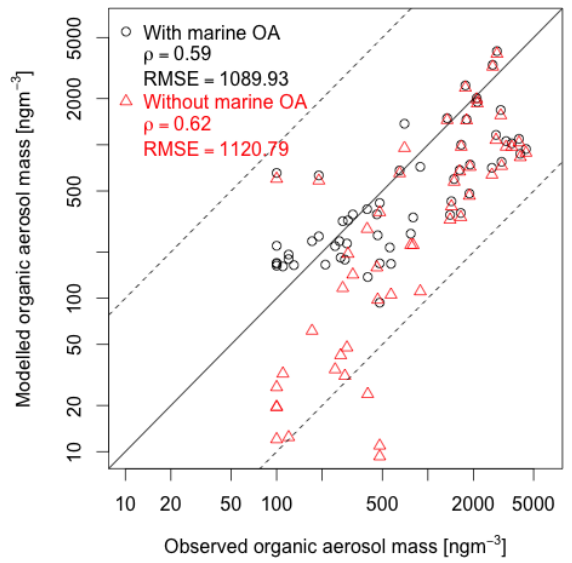
Figure 5. Observed versus simulated total OC mass concentration at observational stations (ngm − 3 ); observations are the same as those shown in Fig. 4. Black circles and red triangles are model climatological values (matched by month to observations and inter- polated to observation location), from INT_ADD simulation, with and without MOA. Following Tsigaridis et al. (2013), the sum of Aitken- and accumulation-mode organic carbon mass is compared with PM 2 . 5 OC observations compiled in Bahadur et al. (2009), from marine observations originally published in Rau and Khalil (1993), Quinn et al. (2000), Ramanathan et al. (2001), Quinn et al. (2004), Bates et al. (2005), Quinn et al. (2006), and Quinn et al. (2008). Model OM values were converted to OC using the follow- ing OM : OC ratios: 1.8 (MOA : MOC), 1.9 (SOA : SOC), and 1.4 (POA : POC). Pearson correlation coefficient and root-mean-square error (RMSE) of model and observations are shown for model aerosol with and without marine organic